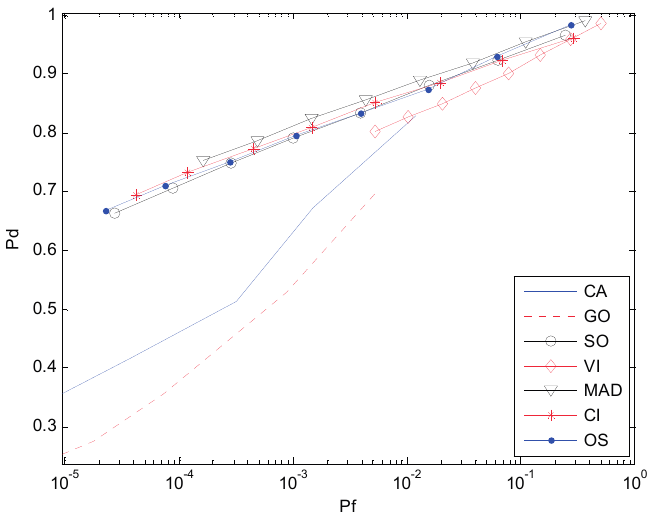
Figure 7. P vs . P (ROC) in the non-homogenous environment with two interferences in d f one half of the reference window, r(0,2).